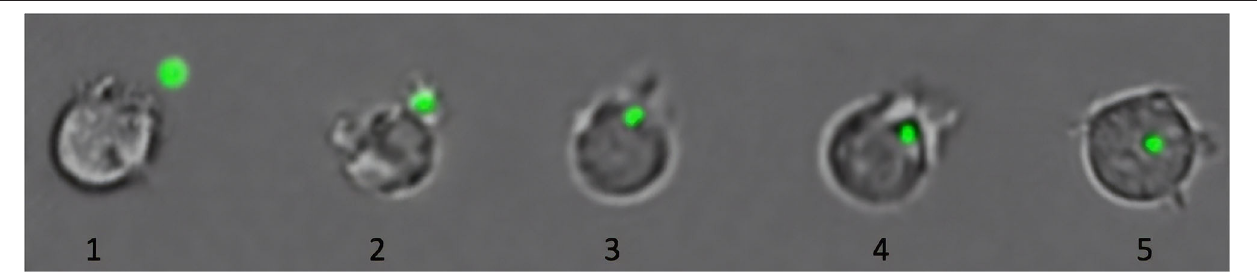
FIGURE 2 | Phagocytosis of microplastics (MPs) by immune cells of Atlantic salmon. As shown in this figure, cells ingest MP (green fluorescent particle) by performing the first steps of phagocytosis: detection and recognition of the MP (1), attachment of the cell to the MP by formation of pseudopods (2), and internalization of the MP (3–5) (Esteban et al., 2015). The last steps of the phagocytosis, involved in the digestion of the particle, are not present due to the lack of specific pathways to degrade plastic (Gewert et al., 2015). The collated images are from representative pictures of five different cells captured at different phagocytic stages. Cells are not to scale.